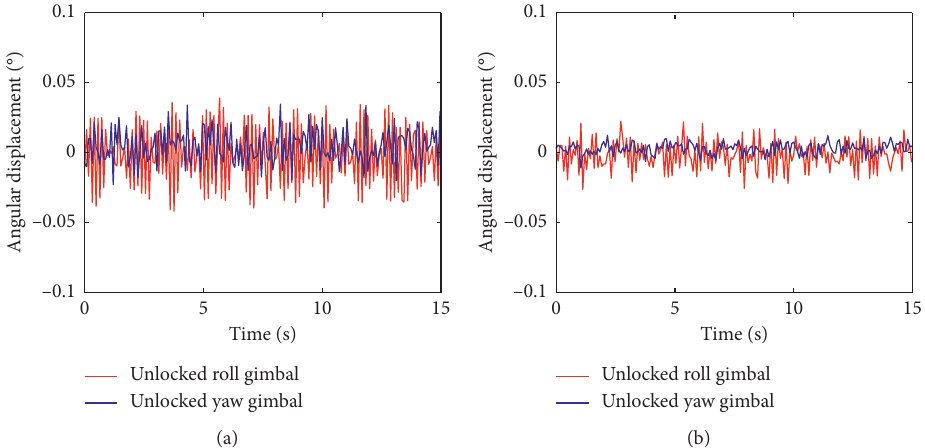
Figure 17: Angular displacements of roll and yaw gimbals with static base plate: (a) without cross-feedback and (b) with cross-feedback. Table 3: Attitude stabilization precision of roll and yaw gimbal with static base plate. Without cross-feedback With cross-feedback Reduction RMS of roll gimbal 0.0229 ° 0.0105 ° 54 RMS of yaw gimbal 0.0129 ° 0.0049 °